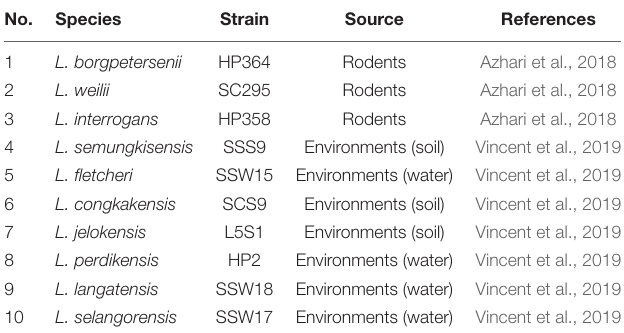
TABLE 1 | List of Leptospira species used in in vivo